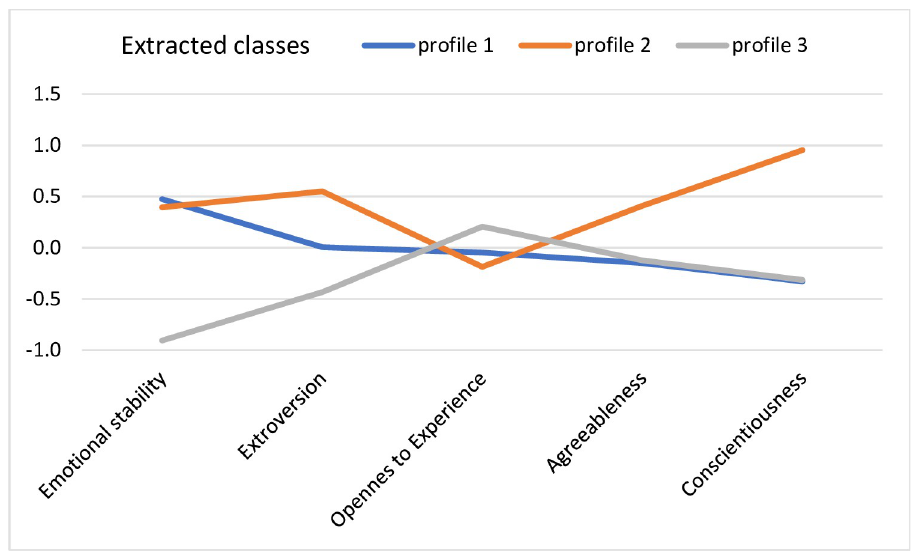
Fig 1. Profiles of personality acquired in the group of young adults.